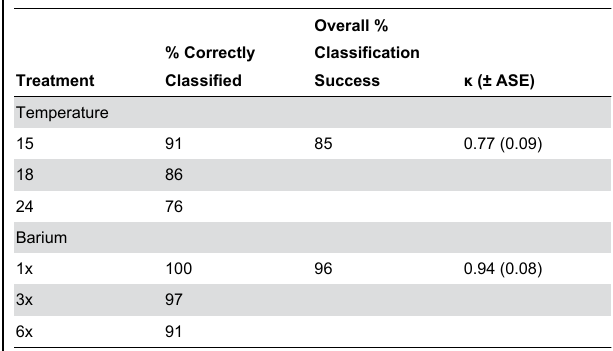
Jack-knife classification success among groups based on known, controlled temperature and dissolved barium concentration histories. Overall percent classification success of groups and chance-corrected classification (κ) ± approximate standard error (ASE) represent independent measures of group classification